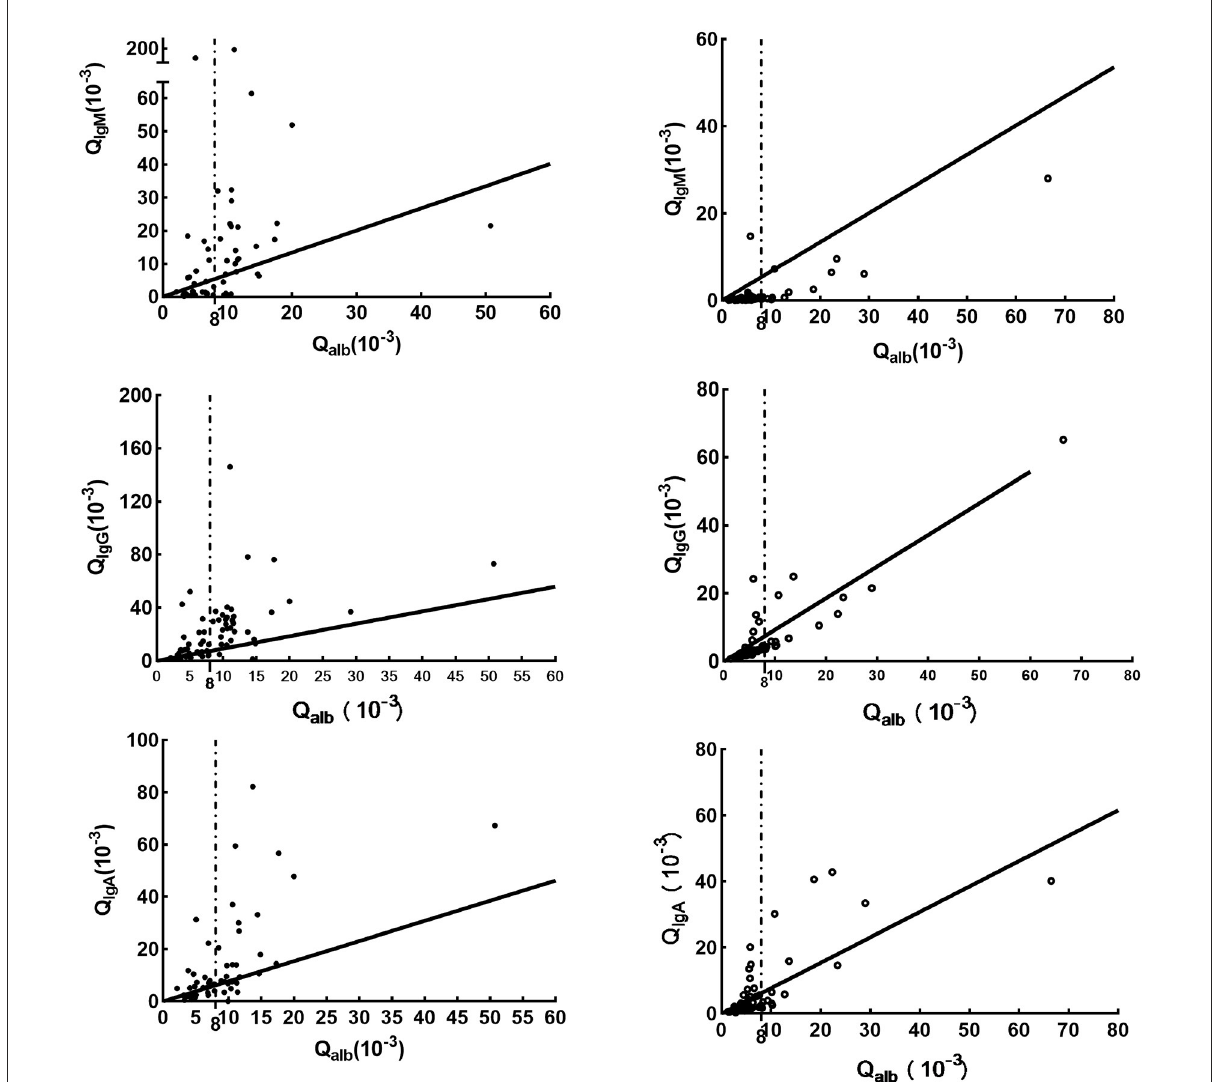
FIGURE1 Ig quotient diagram with hyperbolic curves for the upper discrimination line (Q Lim ) of the reference range for blood-derived Ig in CSF. The dark line is Qlim, the upper limit of the reference range for blood-derived Ig in CSF; the dashed line, indicates Qalb(10 − 3 ) > 8; the solid point represents the cases in the NS group, while the hollow point indicates the cases in the N-NS group. Parameters for the calculation of the hyperbolic curves are obtained from a previous study (23).